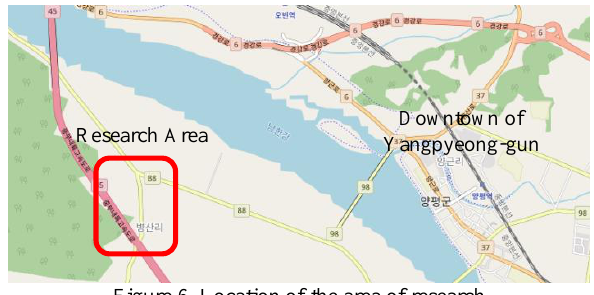
Figure 6. Location of the area of research